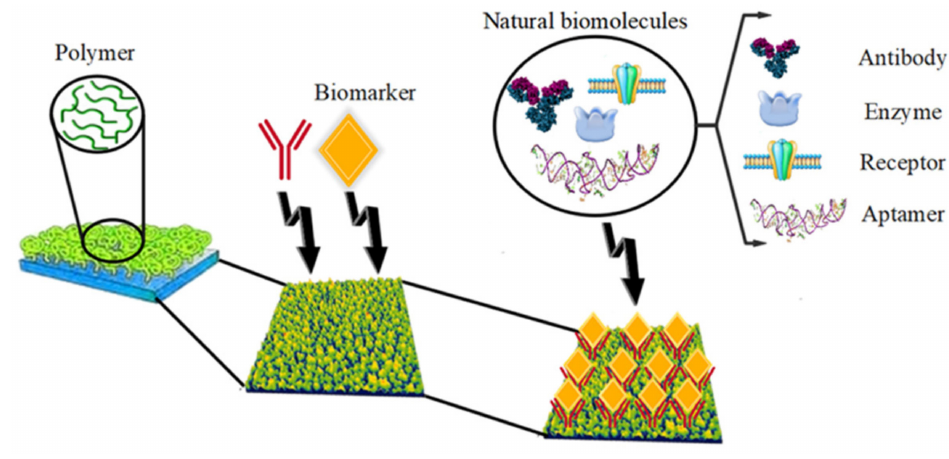
Figure 1. Polymer